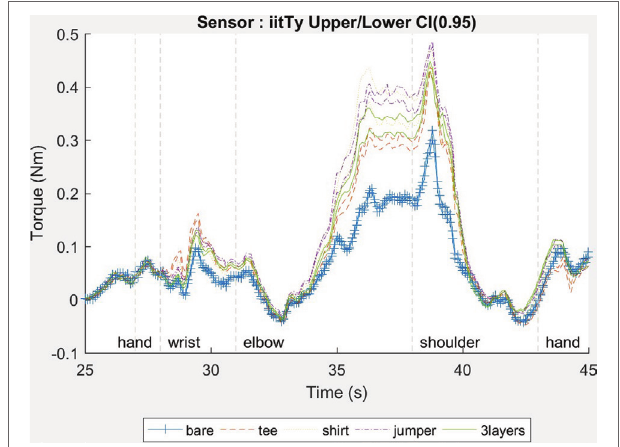
FigUre 7 | example of iiT torque ( y -axis) upper and lower confidence interval for each base layer (pose = 2)